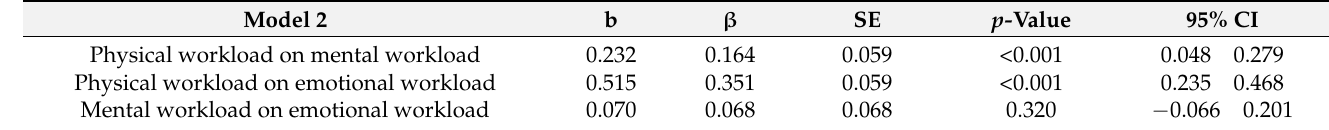
Table 3. Effects of one dimension of nurses’ workload on the others (physical, mental, and emotional workloads) (N =